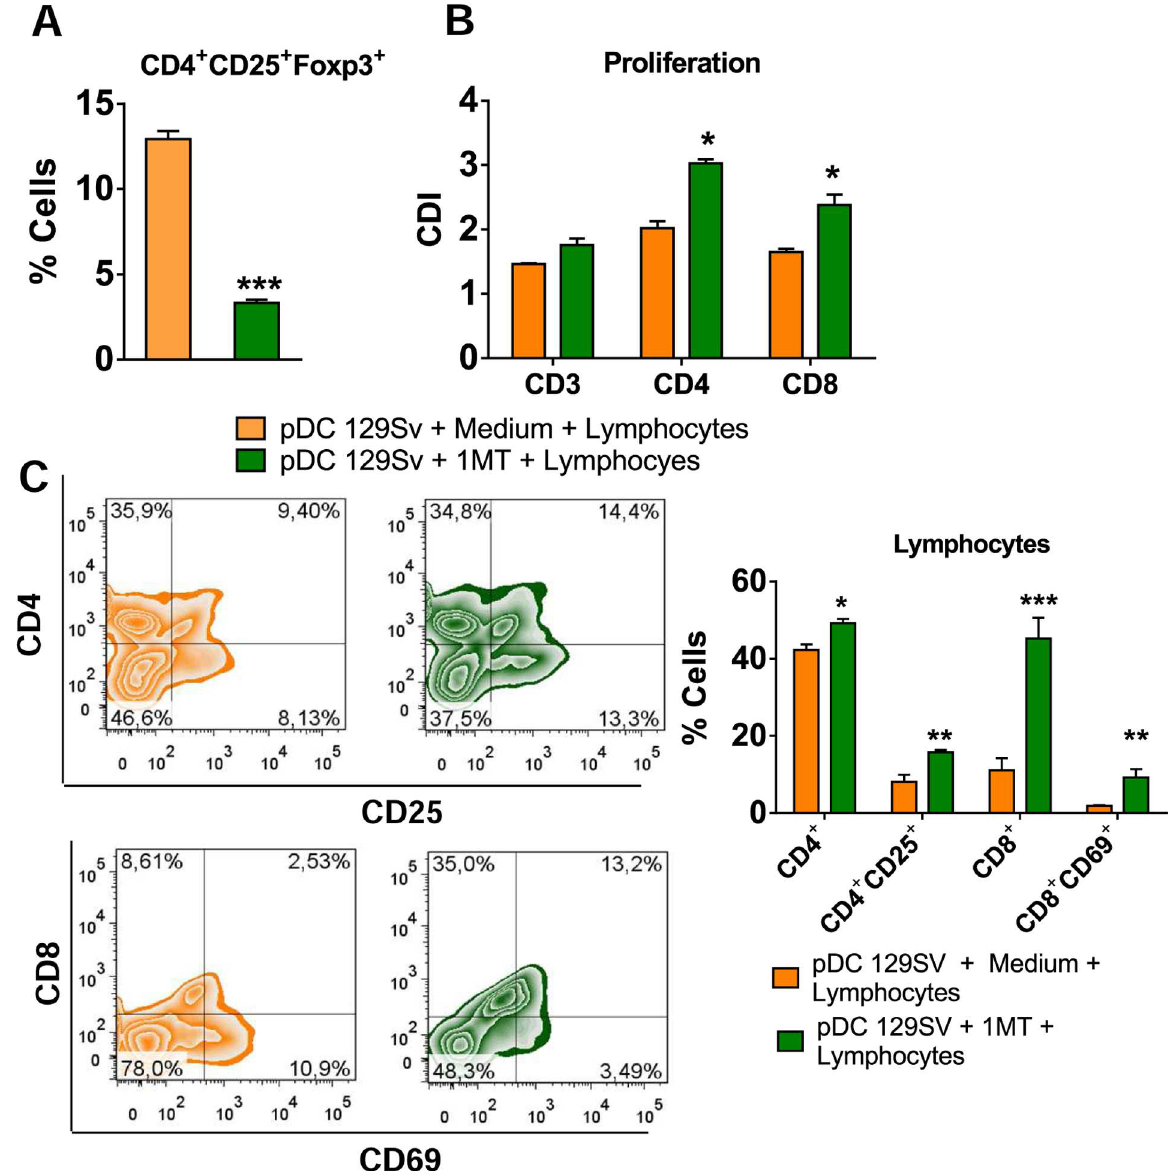
Fig 10. Impaired T cell responses promoted by pDCs is dependent on IDO activity. pDCs were isolatedfrom lungs of uninfected 129Sv mice using magnetics beadsanti-mPDCA. The pDCs (5 x 10 4 ) were treated or not with 1MT (1mM), matured with P . brasiliensis yeasts (1:10; Pb:pDC ratio) and then co-cultured for 7 days with splenicCD3 + lymphocytes (1:10; pDC:lymphocytes ratio) isolated by anti-CD3magneticbeadsfrom WT mice. (A) Frequency of CD4 + Foxp3 + T cells analyzedby flow cytometry. (B) Spleniclymphocytes from uninfected WT mice were previouslylabeledwith CFSE (5 mM) and co-cultured with P . brasiliensis -infected pDCs. The co-culture was kept in the presenceof RPMI mediumcontainingor not 1MT. After 7 days, the cells wereadjustedto 1 × 10 6 , labeledwith specific anti-CD4and CD8 antibodies and analyzedby flow cytometry. (C) After 7 days of co-culturewith infected pDCs, lymphocytes were adjustedto 1 × 10 6 , labeledwith specificanti-CD4,CD8, CD25, and CD69antibodiesand analyzedby flow cytometry. The lymphocytes were gated by FSC/SSC analysisand gated cells were analyzedfor the expression of CD4 + CD25 + (top) and CD8 + CD69 + (bottom). Bars reflect mean ± SD of two independent experiments with eight mice per group(right) ( * p <